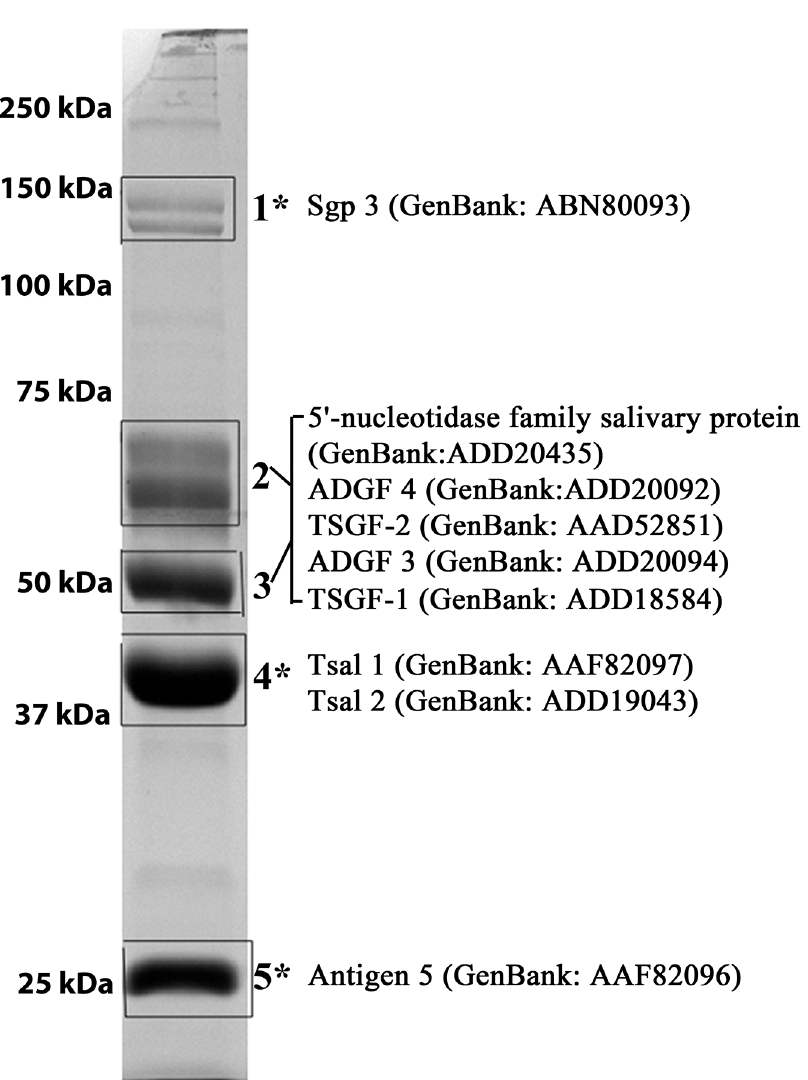
Fig 3. Identification of the major immunogenic and non-immunogenic proteins in Gmm sialome. The most abundant protein bands extracted for LC-MS/MS analysis are shown boxed. Fractions 1, 4 and 5, as marked by “ * ” , correspond to protein bands that were noted as immunogenic in the analysis presented in Fig 2. Protein fractions 2 and 3 were combined representing non-immunogenic proteins.